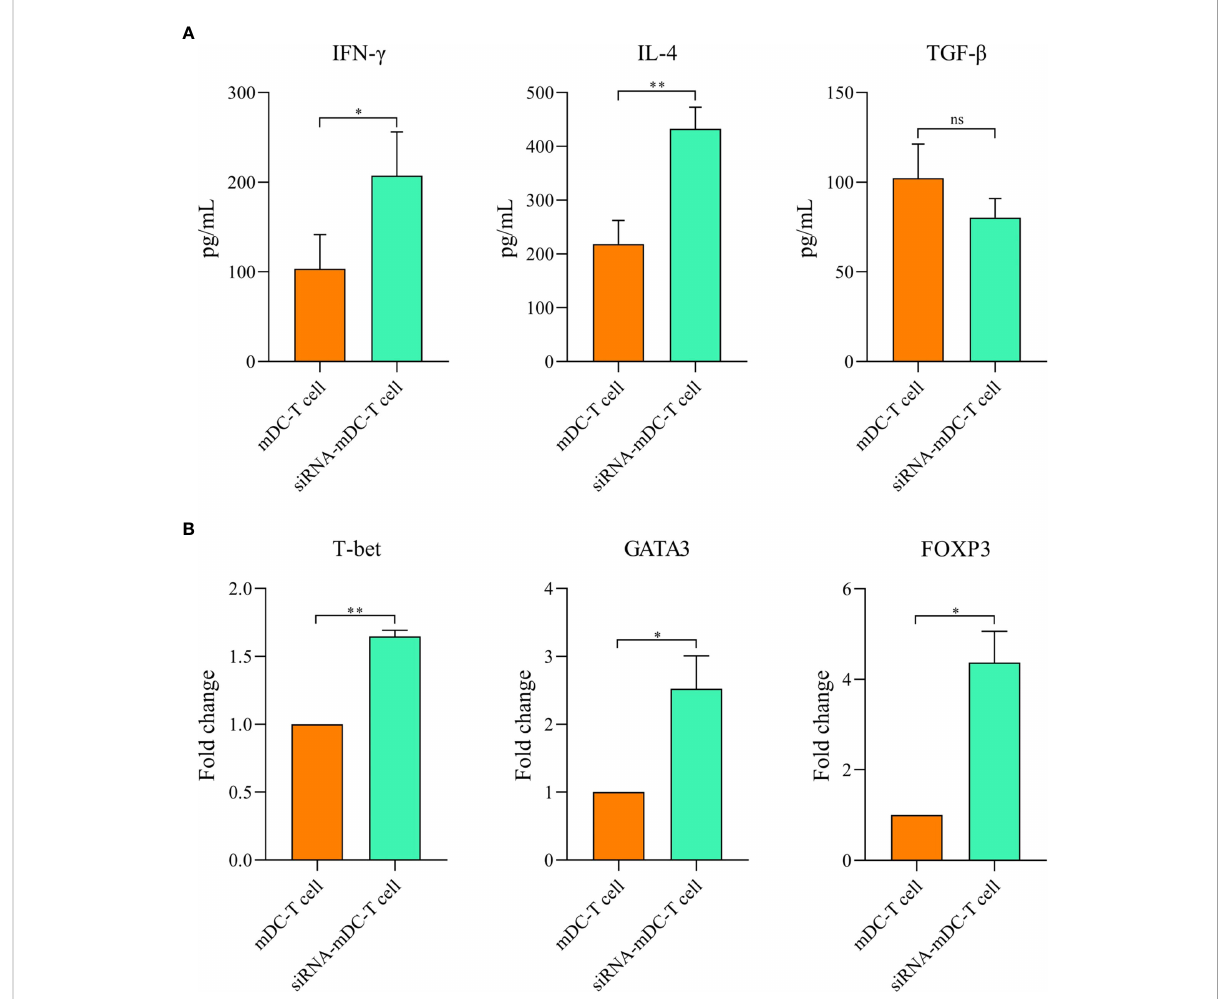
FIGURE 5 Silencing of CTLA-4 in mDCs strengthened T cell-mediated effector functions. Cytokine production by T cells following co-culture with mDCs and CTLA-4-silenced-mDCs. (A) The DC/T cell co-culture supernatants were evaluated for IFN- g , IL-4, and TGF- b secretion by CD3 + T cells by ELISA. (B) Expression analysis of T cell-associated transcription factors, i.e., GATA3, T-bet, and FOXP3 by CD3 + T cells following co-culture with mDCs and CTLA-4-silenced-mDCs were determined via qRT-PCR; (ns, not signi fi cant, *P ≤ 0.05, and **P ≤ 0.01). CTLA-4, Cytotoxic T- lymphocyte-associated protein-4; DC, dendritic cell; mDCs, Tumor cell lysate-loaded mature dendritic cells; siRNA-mDCs, CTLA-4-silenced mDCs; ELISA, Enzyme-linked immunosorbent assay; GATA3, GATA binding protein 3; T-bet, T-box protein expressed in T cells; FOXP3, Forkhead box P3; qRT-PCR, Quantitative reverse transcription polymerase chain